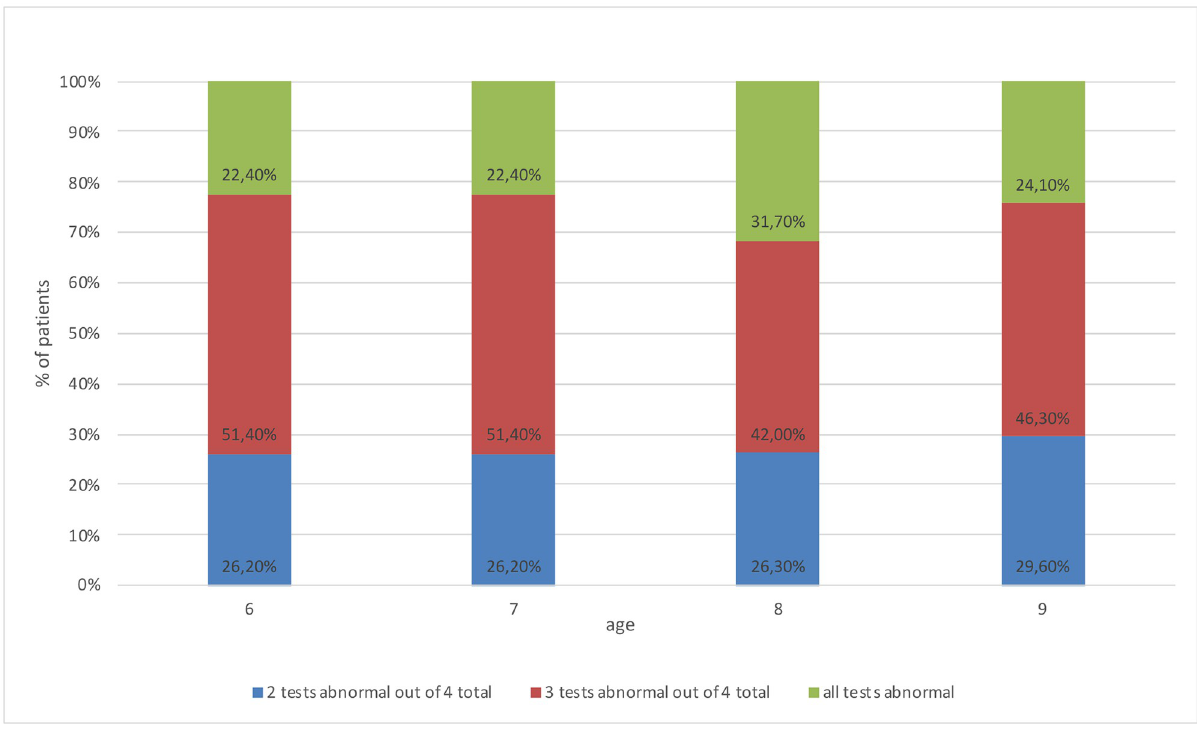
Fig 5. Frequency of abnormal APD test results, by age, in group”S”.